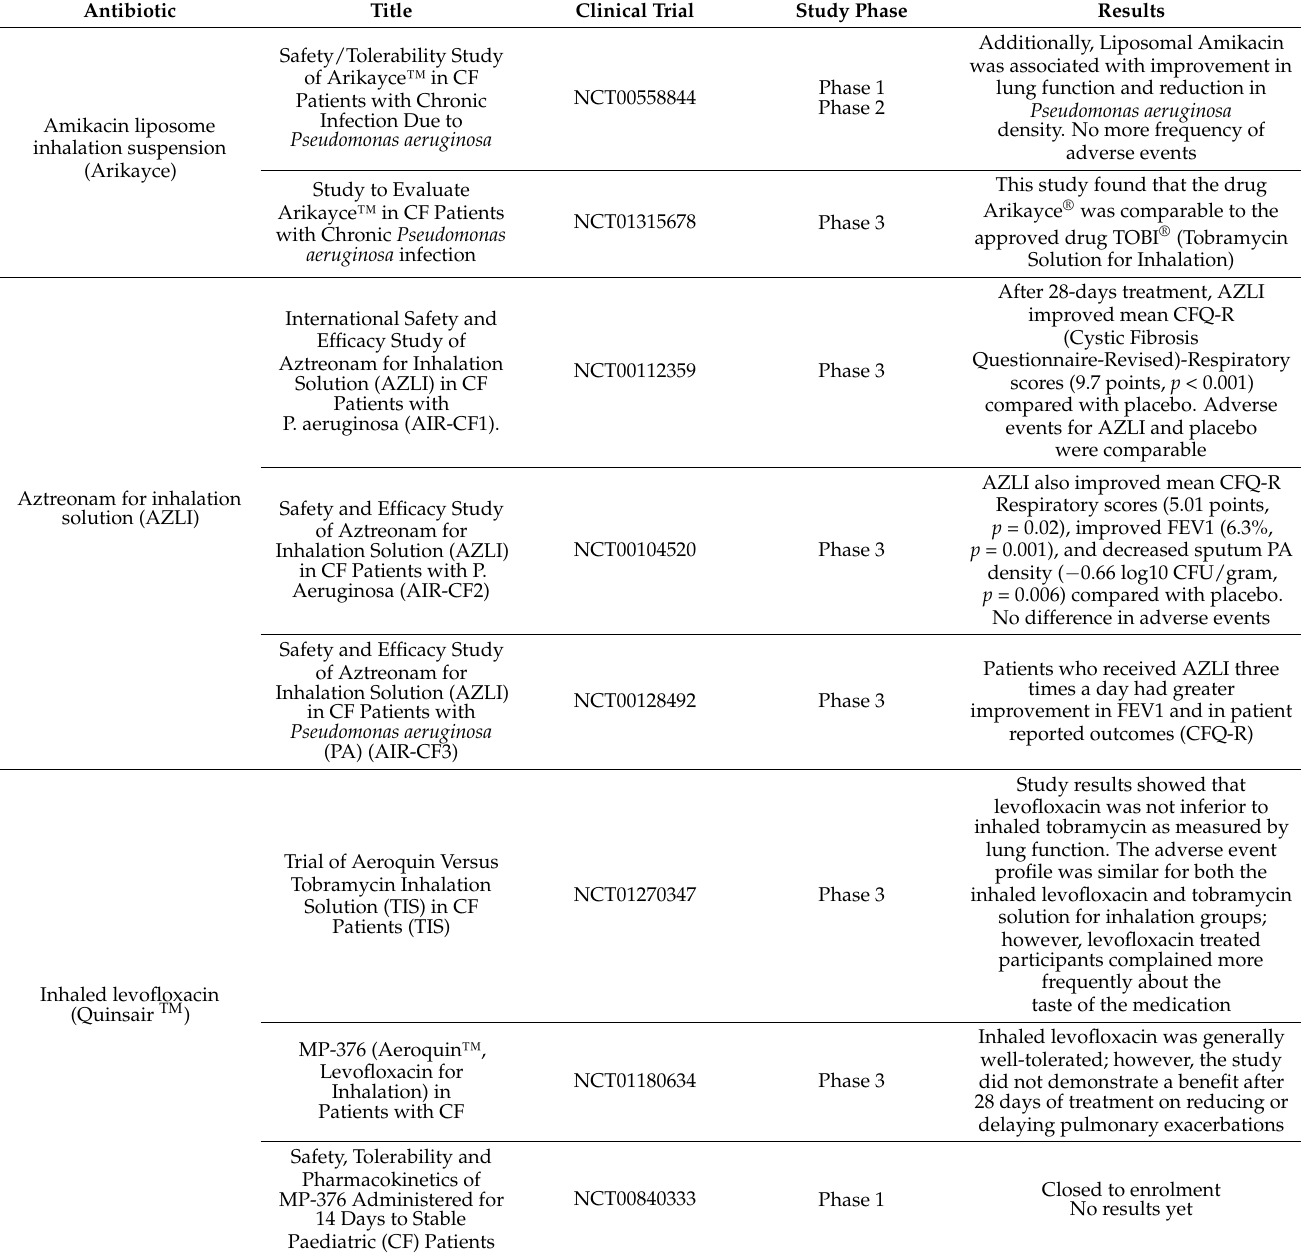
Table 5. Antibiotics research